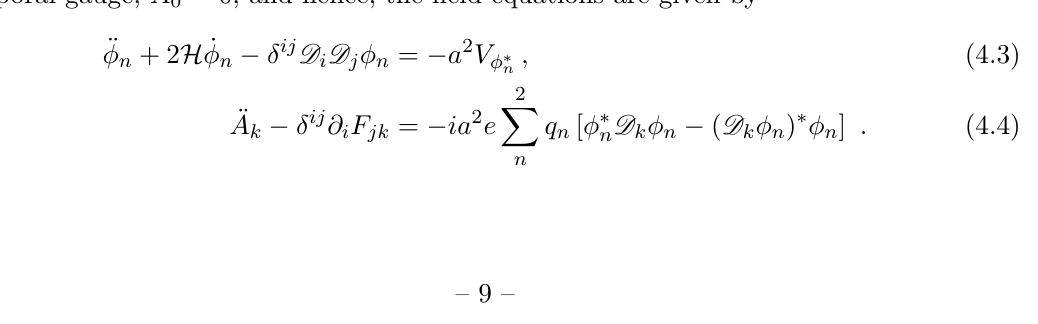
Figure 5 . A schematic picture of the double reconnection of the strings for (cid:12)gure 4. The red rod is a (cid:30) 1 -string with n 1 = 1. The green rod is a (cid:30) 2 -string with n 2 = 1. The arrows on the strings denote the magnetic (cid:13)ux in the strings. The strings are cut for drawing (cid:12)gures. where (cid:28) is the conformal time and a ( (cid:28) ) is the scale factor. In the simulations, we use the temporal gauge, A 0 = 0, and hence, the (cid:12)eld equations are given